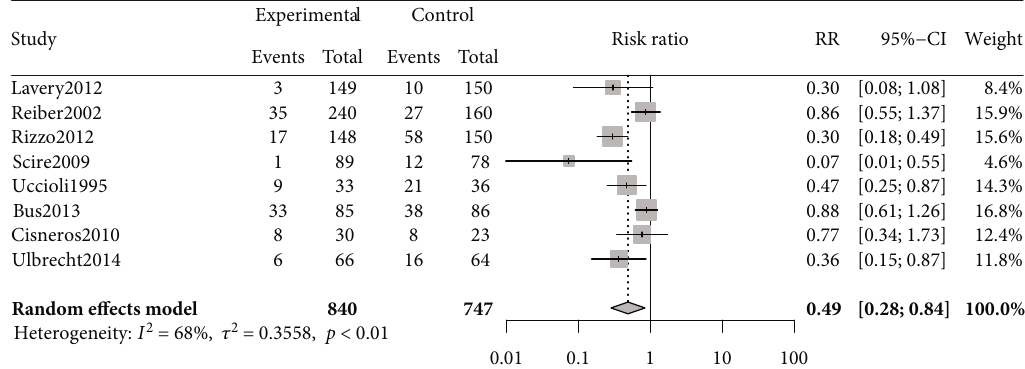
Figure 2: Forest plot of the e ff ect of special therapeutic footwear in reducing the incidence of diabetes-related foot ulcers in 8 RCT studies including 1,587 participants and 302 events. Results are expressed as relative risk (RR) and 95% con fi dence intervals (95% CI). Pooled analysis P < 0 : 05 ; heterogeneity test: I 2 = 68 % , P < 0 : 01